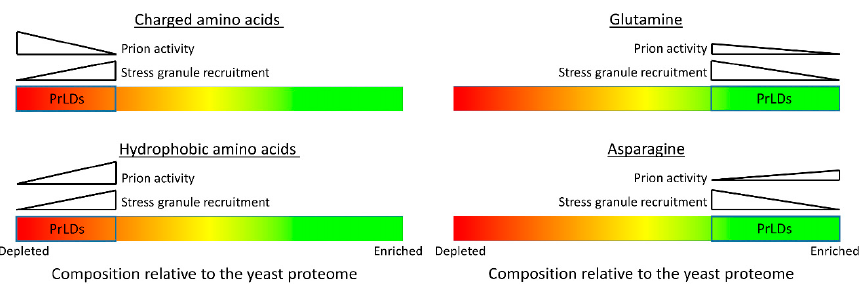
Figure 2. Compositional biases observed in PrLDs. PrLDs show strong compositional biases, including an enrichment in glutamine and asparagine, and a relative lack of charged and hydrophobic amino acids compared with the average of the yeast proteome. In yeast, screens of PrLDs have shown that different compositional features of PrLDs are associated with prion propensity [10,58] versus stress granule recruitment [73]. It is important to note that this figure represents general trends that were observed in these screens and, therefore, may not reflect the behavior of all PrLDs.